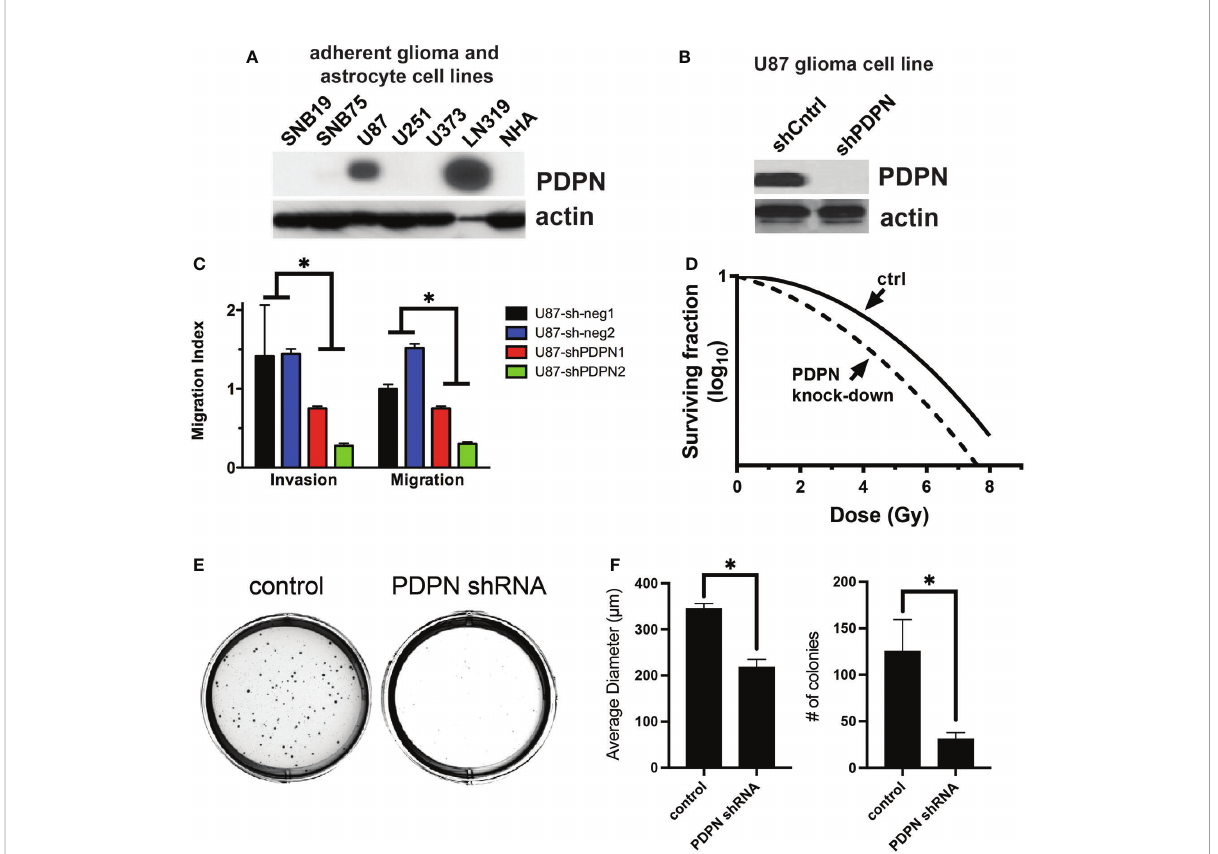
FIGURE 3 PDPN knockdown sensitizes adherent glioma cell lines to radiation and reduces invasion, migration, and colony formation ability. (A) PDPN expression in adherent glioma cell lines and normal human astrocytes (NHA). (B) Western blot of PDPN knockdown in U87 cell lines. (C) Invasion and migration assays of U87 PDPN knockdown lines (*p<0.005, multiple t-tests, sh-neg vs . sh-PDPN). (D) Clonogenic radiation survival assay with PDPN knockdown lines, PDPN silencing sensitized U87 cells to in vitro radiation compared with controls. (E) Representative crystal violet stains after a colony formation assay with U87 PDPN knockdown lines. (F) Quanti fi cation of colony diameter and colony number after colony formation assay of control and PDPN shRNA cell lines (*p<0.005, two tailed